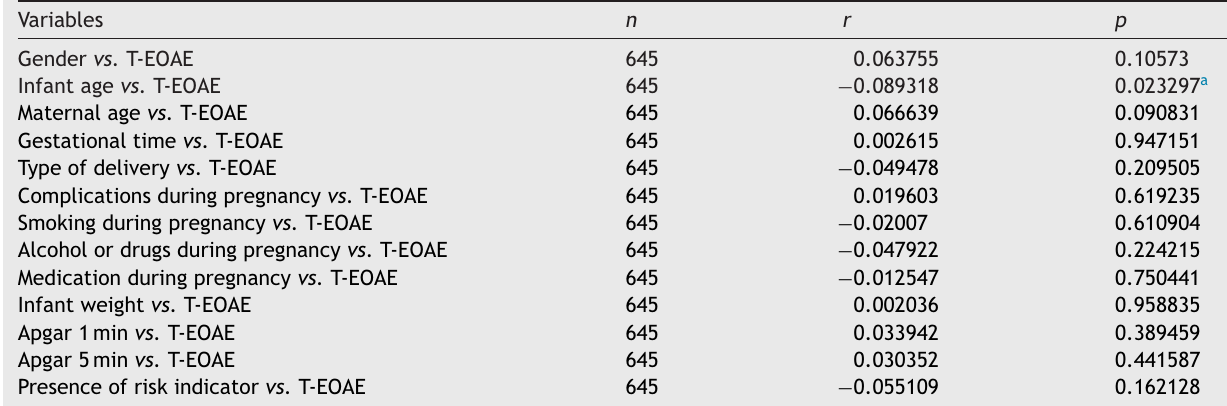
Table 4 Correlation among variables studied with the results of transient evoked otoacoustic emissions.